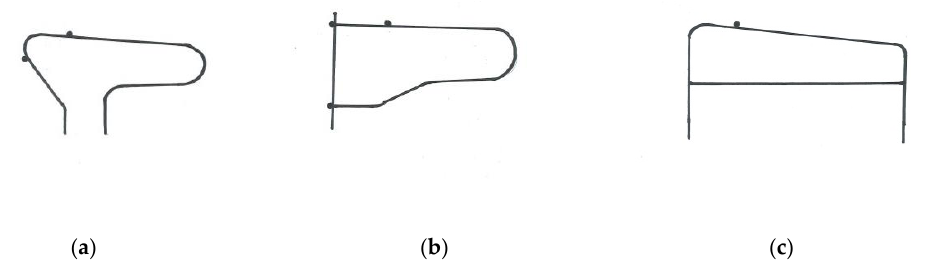
Figure 3. Divider types for dairy cows in cubicles. ( a ) R-shaped divider; ( b ) U-shaped or free-hanging divider; ( c ) English type divider.